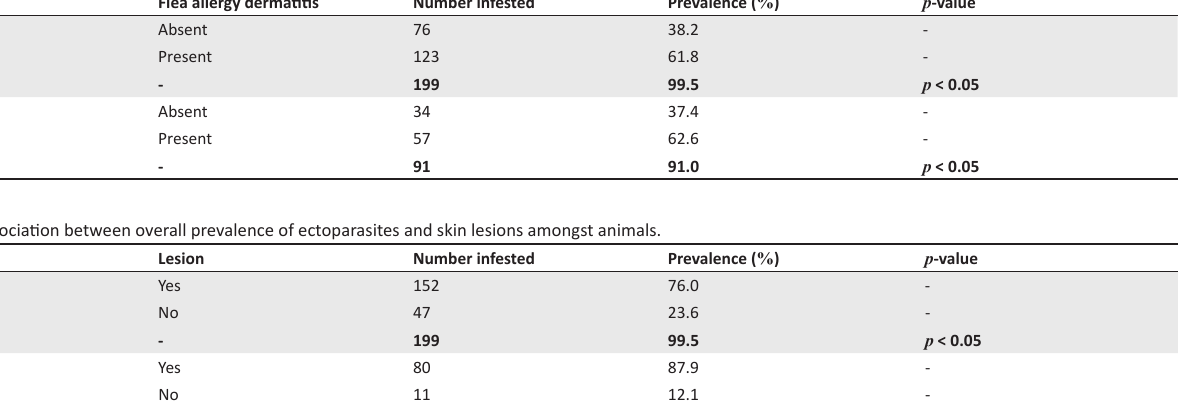
TABLE 5: Overall prevalence of ectoparasites on dogs and cats with and without flea allergy dermatitis. Animal Flea allergy dermatitis